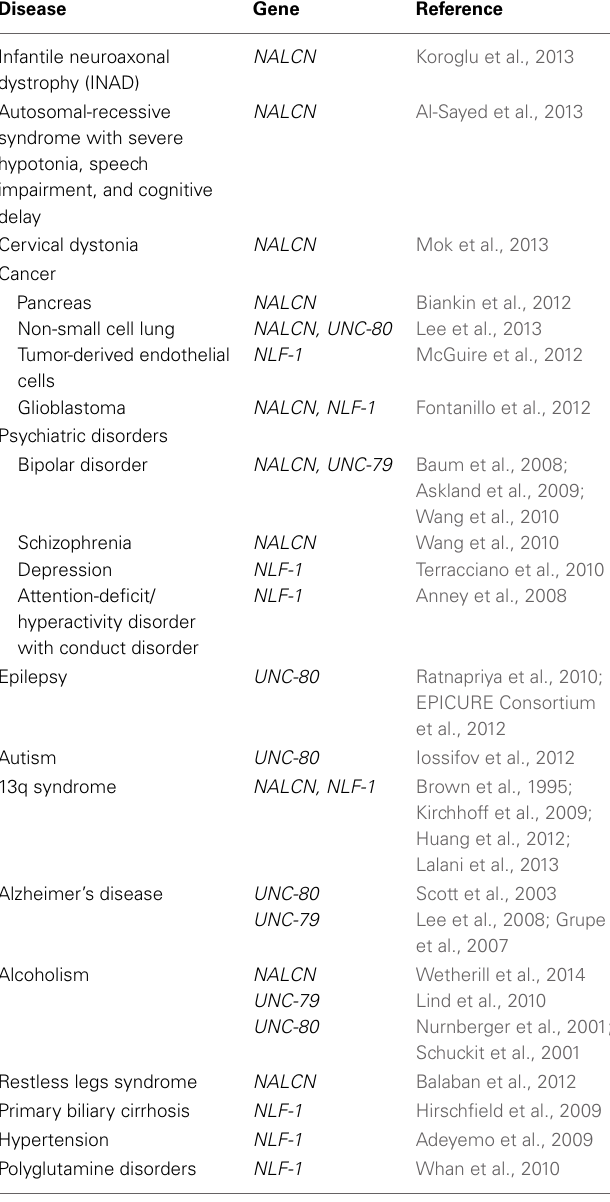
Table 3 | Possible implications of the NALCN channel complex in